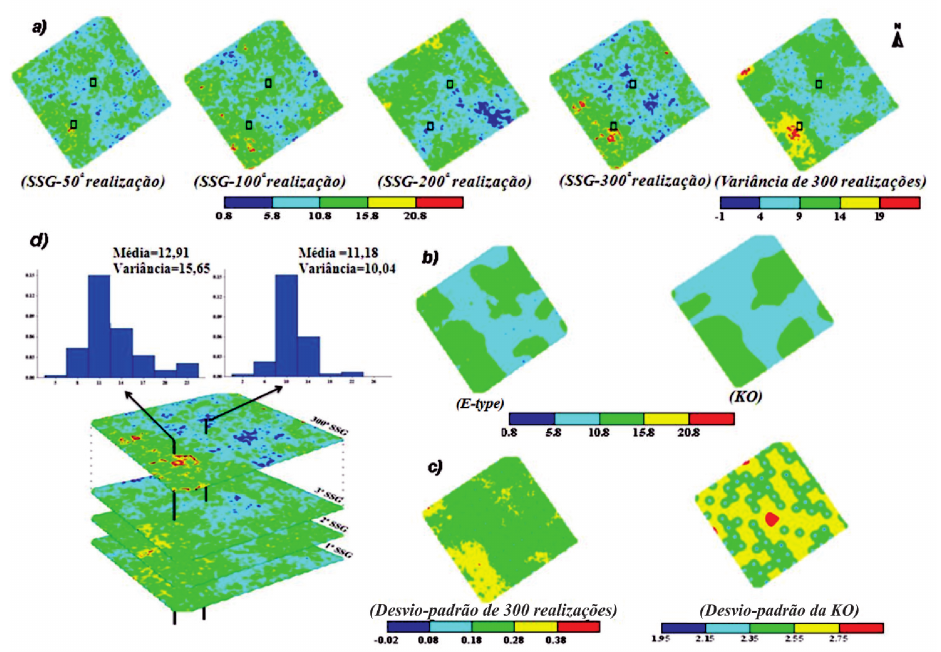
Figura 2. Mapas das realizações (50ª, 100ª, 200ª e 300ª) e variância de 300 realizações (a), mapas das estimativas E-type e KO (b), mapas do desvio-padrão de 300 realizações e da KO (c) e incertezas locais de dois pontos da área (d) dos teores de Gt na pedoforma côncava.